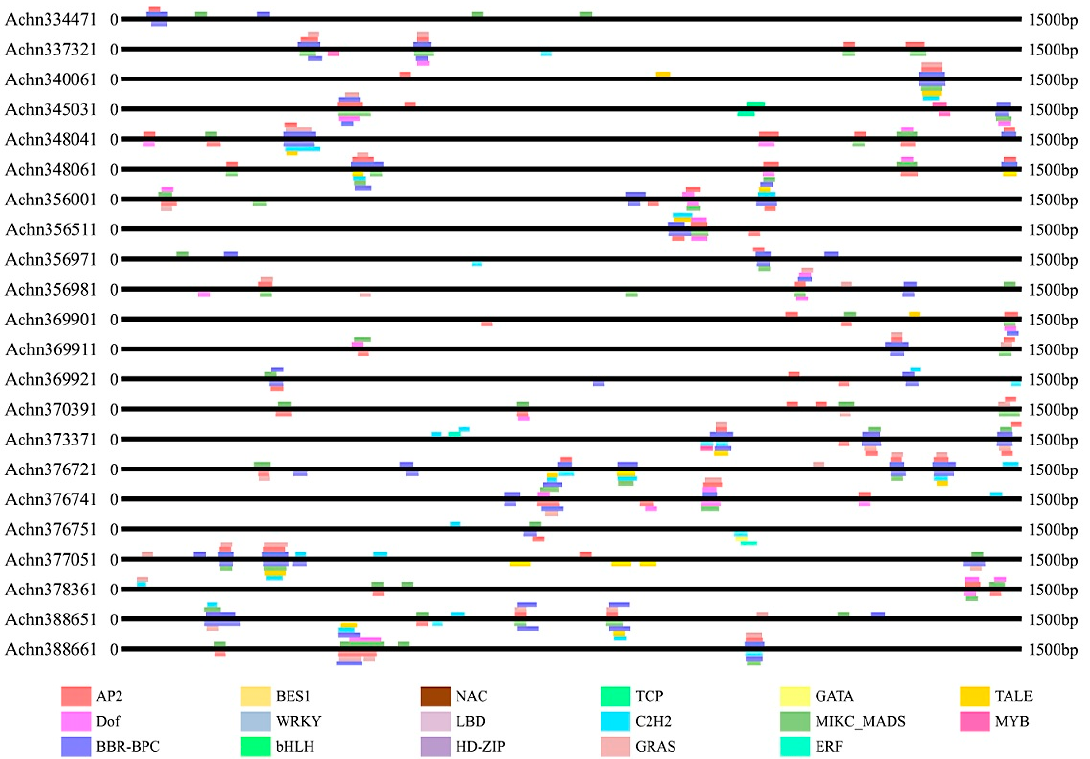
Figure 3. Cis-acting elements of promoters of 22 representative NBS-LRR genes. Cis-elements were predicted and analyzed using the PALCE database. Data of all the 100 NBS-LRR genes are displayed in Figure S1.